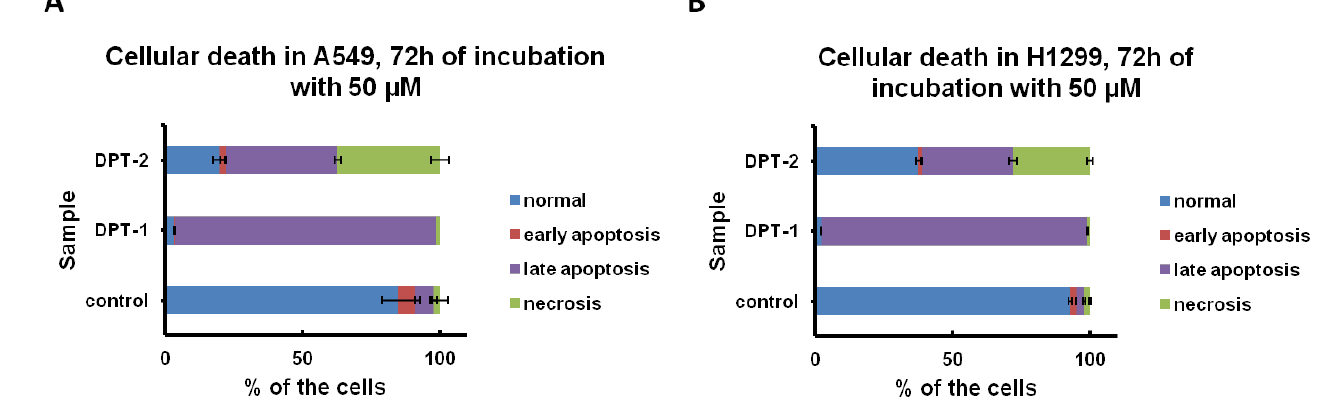
Figure 7. Cellular death in control and DPT-1 - and DPT-2 -treated A549 ( A ) and H1299 cells ( B ) treated for 72 h at a dose of 50 µM, followed by flow cytometry measurements of Annexin-V apoptosis assay and iodium propide (PI) staining (normal cells: Annexin-V − /PI − ; early apoptosis: Annexin-V + /PI − ; late apoptosis: Annexin-V + /PI + ; necrosis: Annexin-V − /PI + ).